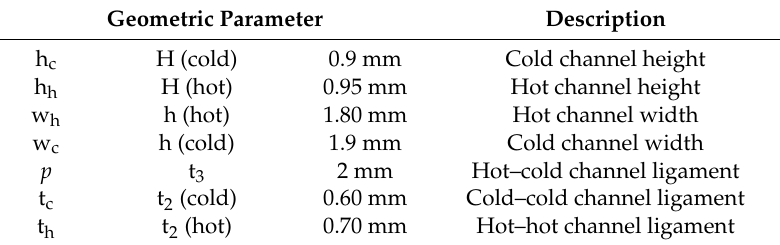
Figure 2. Proposed design cross-section geometry parameters. Table 2. Geometric parameter of this study.